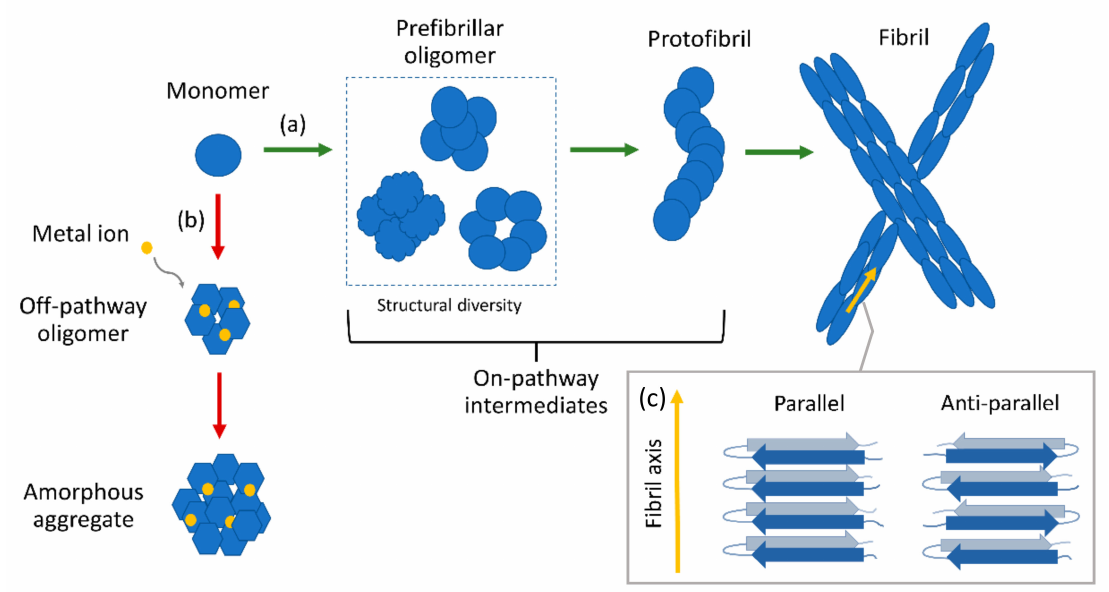
Figure 1. Schematic illustration of amyloid aggregation. ( a ) On-pathway mechanism: native monomers misfold and undergo conformational change to form prefibrillar oligomers, protofib- rils, and mature fibrils. ( b ) Alternative pathway induced by metal ions: monomers form off-pathway oligomers which do not end up as fibrils but amorphous aggregates. ( c ) Schematic illustration of parallel and anti-parallel cross- β structure. Amyloid fibrils have parallel cross- β